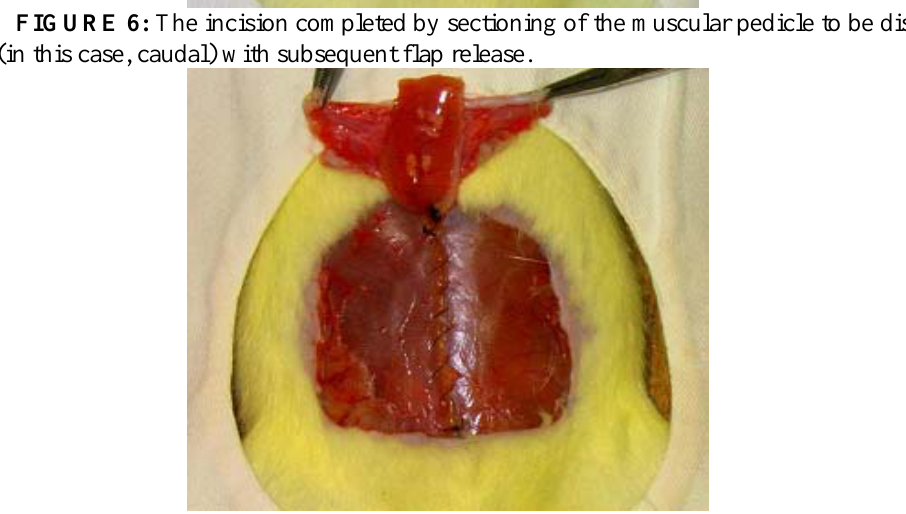
FIGURE 7: Suture of aponeurotic plane with monofilamentar nylon 5.0 thread without stressing the pedicle of chosen